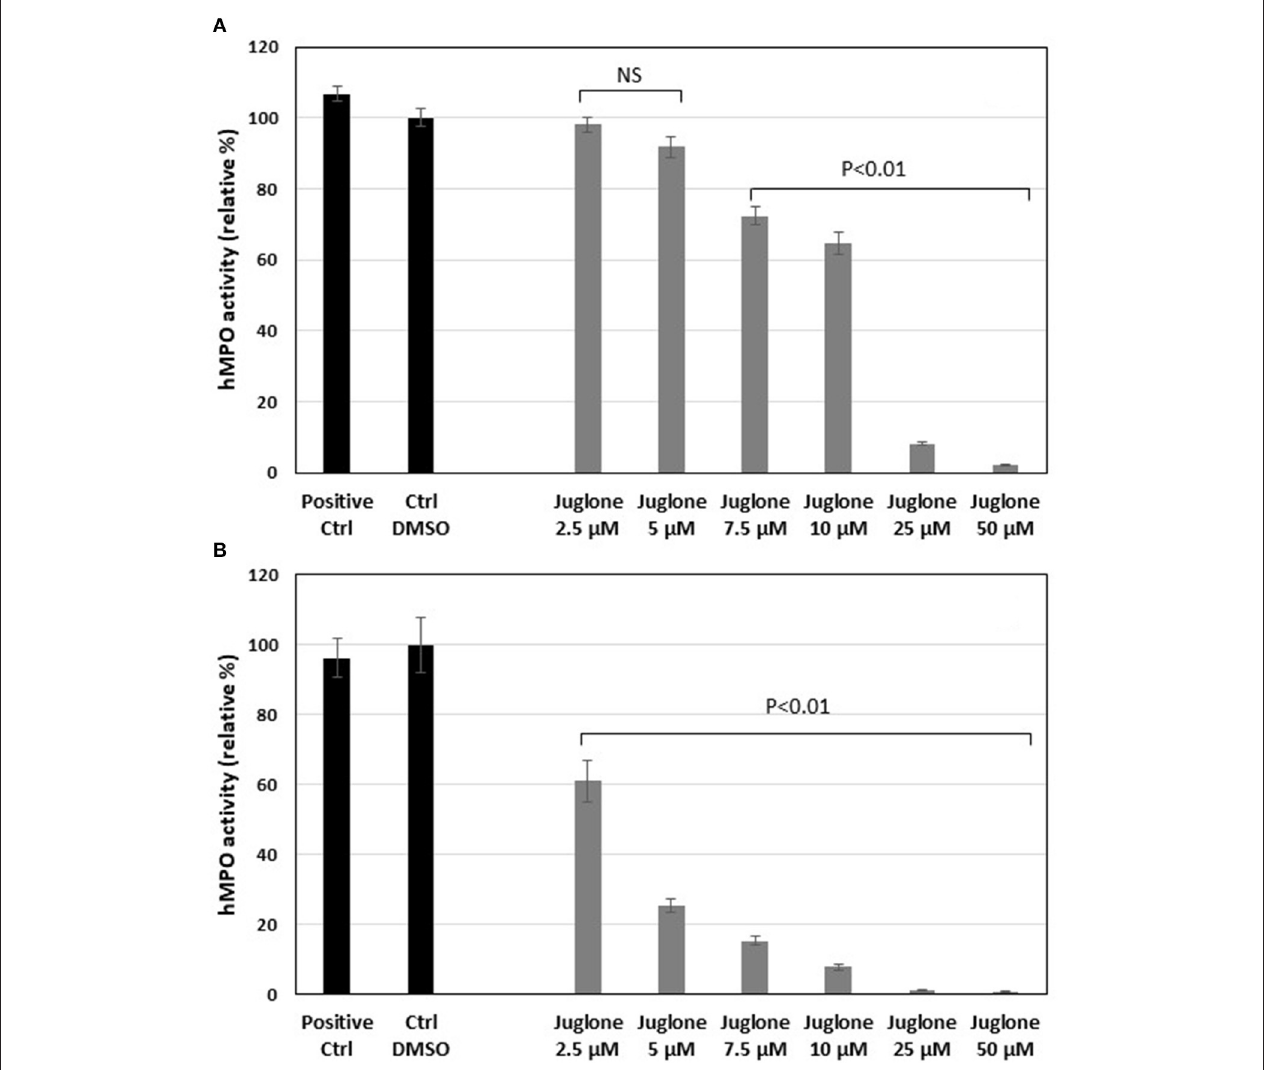
FIGURE 5 | Effects of increasing concentrations of juglone on human myeloperoxidase (MPO) measured by a classical enzymatic assay (A) or by the specific immunological extraction followed by enzymatic detection (SIEFED) assay (B) . The results are the mean ± SD ( n = 4). Positive Ctrl , PBS with MPO alone; Ctrl DMSO , control with 1% dimethyl sulfoxide (DMSO). Values of p are vs. DMSO control taken as 100% activity of MPO. NS , not